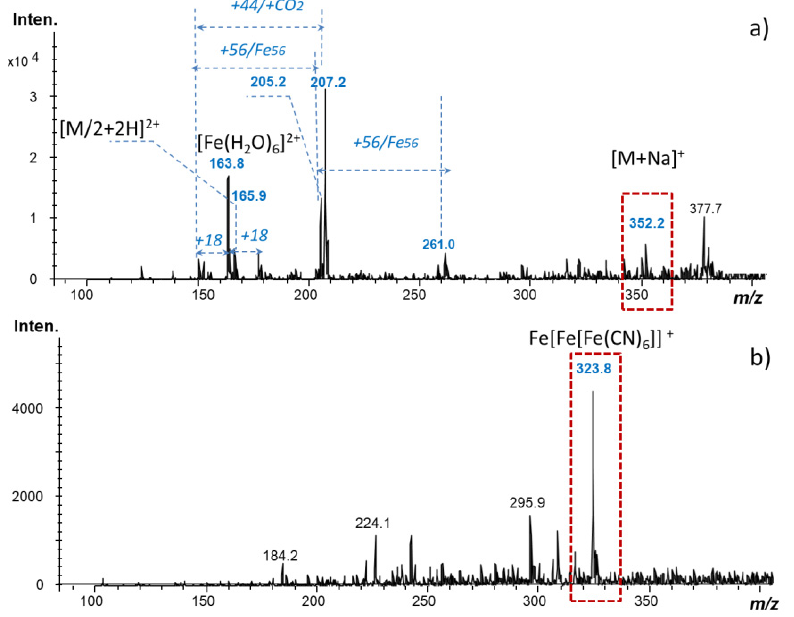
Figure 6. LDI-MS spectra obtained from glucose test-strips modified by as-prepared 10CMC/200FC/20ALG/9GOx gel in CitB ( a ) and after its storage for 3 days in the light access ( b